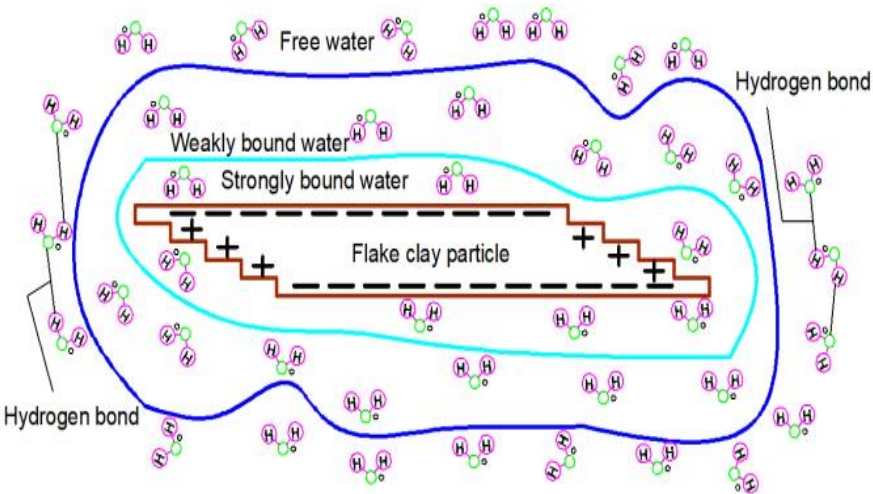
Figure 7. Bound water distributed on a clay particle surface.